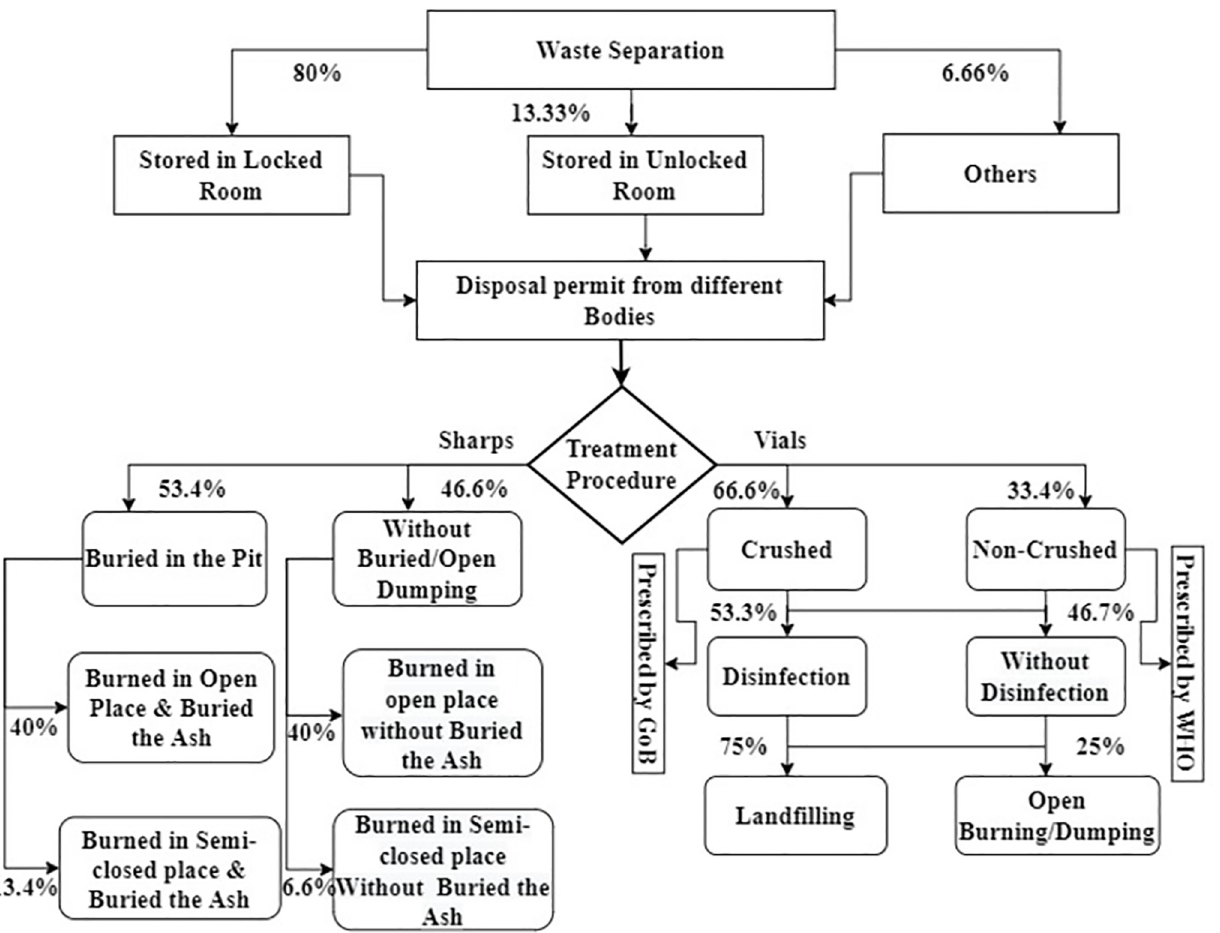
Fig 2. Flowchart of existing COVID-19 vaccine waste management in the studied area (% in the figure denotes the number of hospital practicing the management procedure).